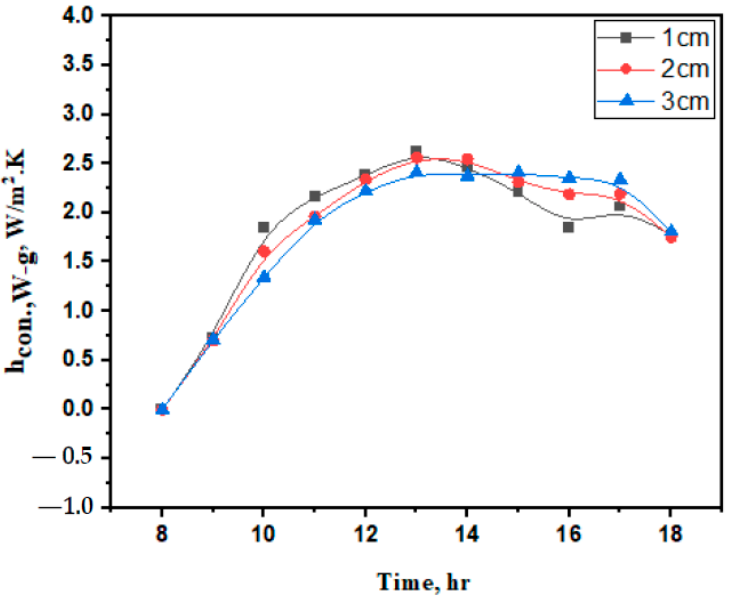
Figure 8. Influence of water depth on heat transfer coefficient by convective.